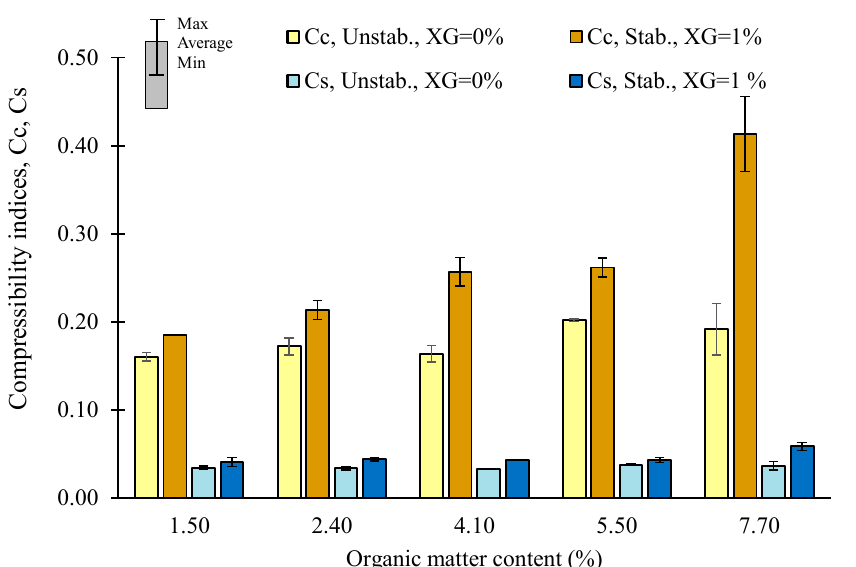
Figure 8. Oedometer tests. Effect of organic matter content on the compressibility indices, Cc and Cs.